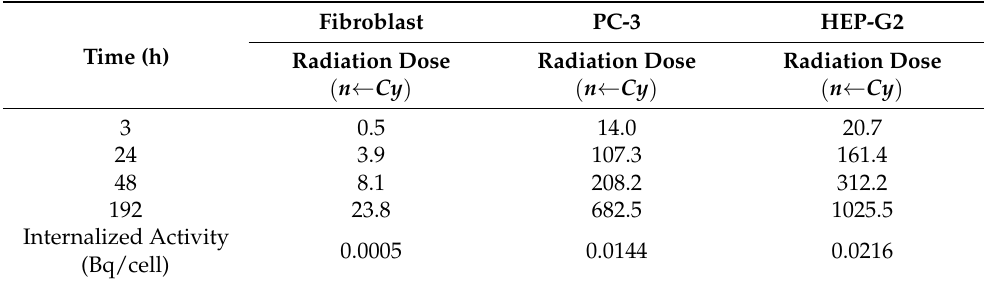
Table 2. Mean radiation-absorbed dose ( Gy ) from the cytoplasm ( Cy ) to the cell nucleus ( n ), con- sidering the internalized activity (Bq/cell) with respect to the total initial activity administered